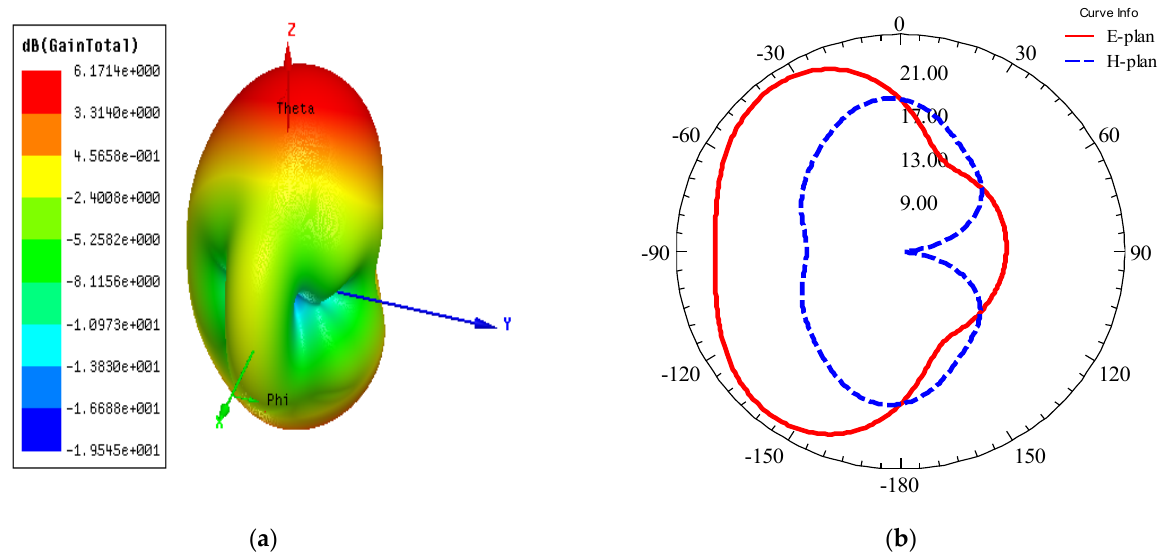
Figure 18. Distribution of E-field of Slot antenna 4 at 2450 MHz.